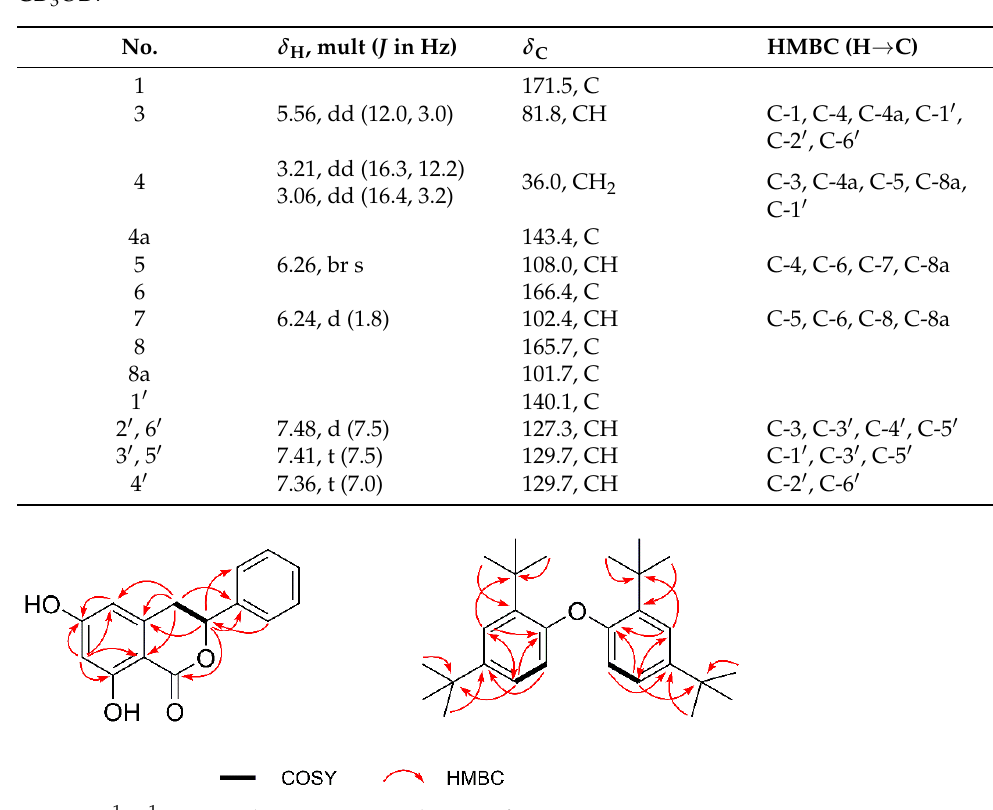
Table 1. 1 H-NMR (600 MHz), 13 C NMR (150 MHz) data, and HMBC correlations of compound 1 in